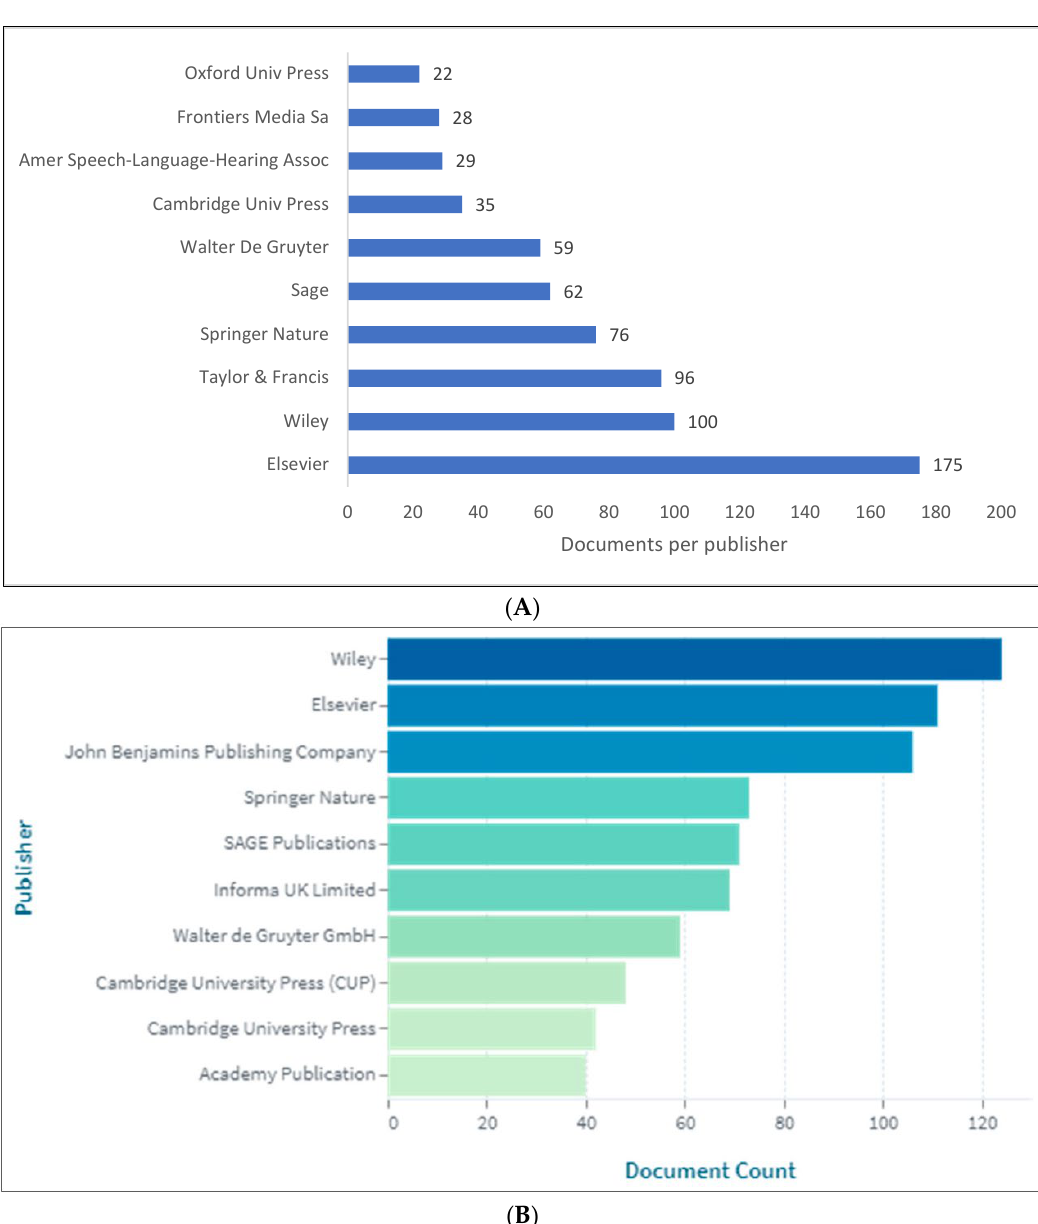
19 of 47 Figure 4. Pragmatic language development knowledge production size by journal: ( A ) Scopus; ( B ) WOS; ( C ) Lens; ( D ) Lens.